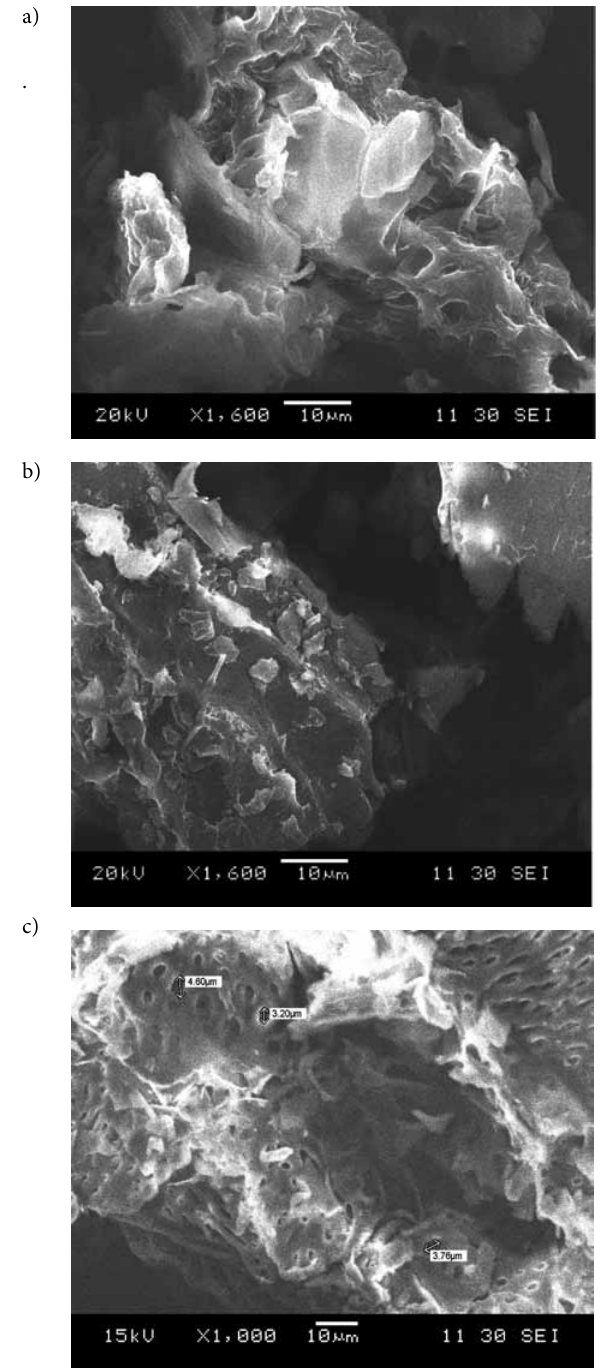
Fig. 6. SEM micrographs of untreated peanut husk, chemically activated peanut husk; and chemically activated peanut husk after adsorption: a) peanut husk; b) chemically activated peanut husk c) chemically activated peanut husk after adsorption